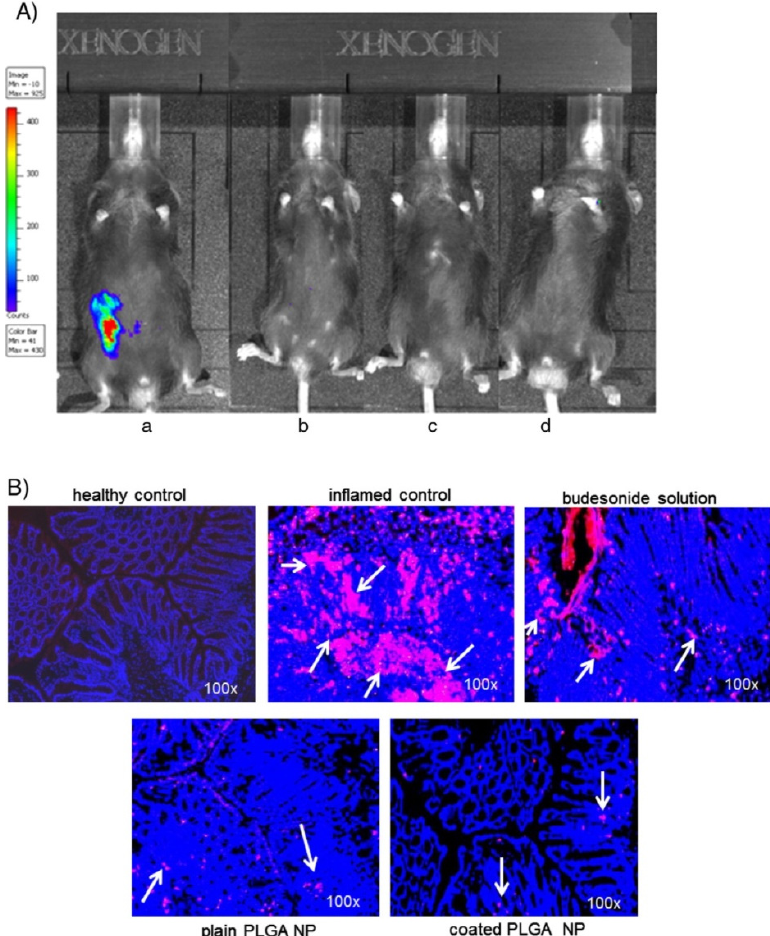
Figure 3. ( A ) In vivo myeloperoxidase (MPO) activity measurement in live mice by luminescence detection. ( a ) inflamed colitis as control, ( b ) free budesonide treated ( c ) treated with budesonide loaded plain nanoparticles, ( d ) treated with budesonide loaded coated nanoparticles. ( B ) Cryosectional study by immunohistochemical technique where the coated nanoparticles showed low extent of granulocytes. Reprinted with permission from